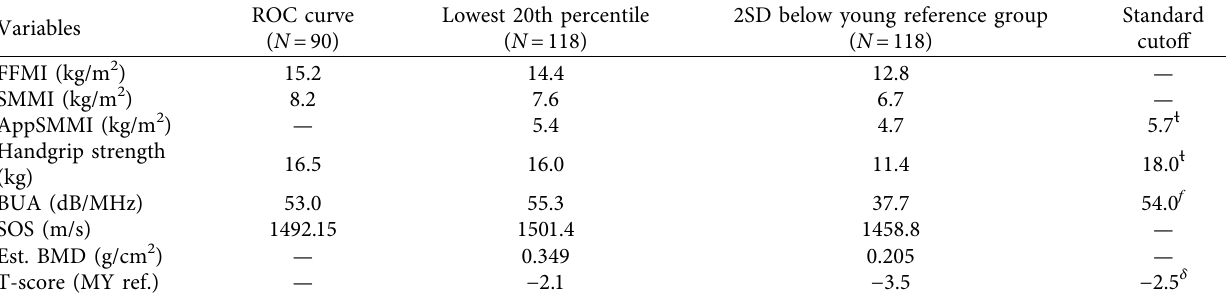
Table 3: Comparison of cutoff values according to different